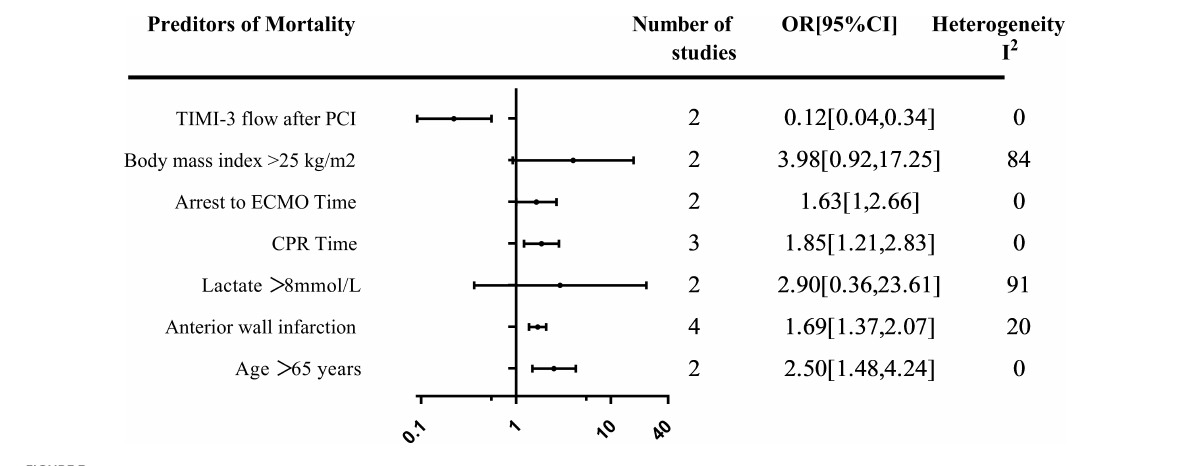
FIGURE3 Summary of meta-analysis of predictors of